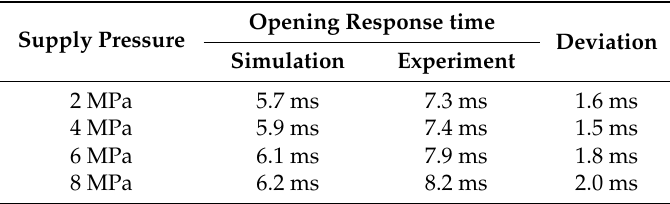
Table 3. Opening response times of VCM-DHPV under different supply